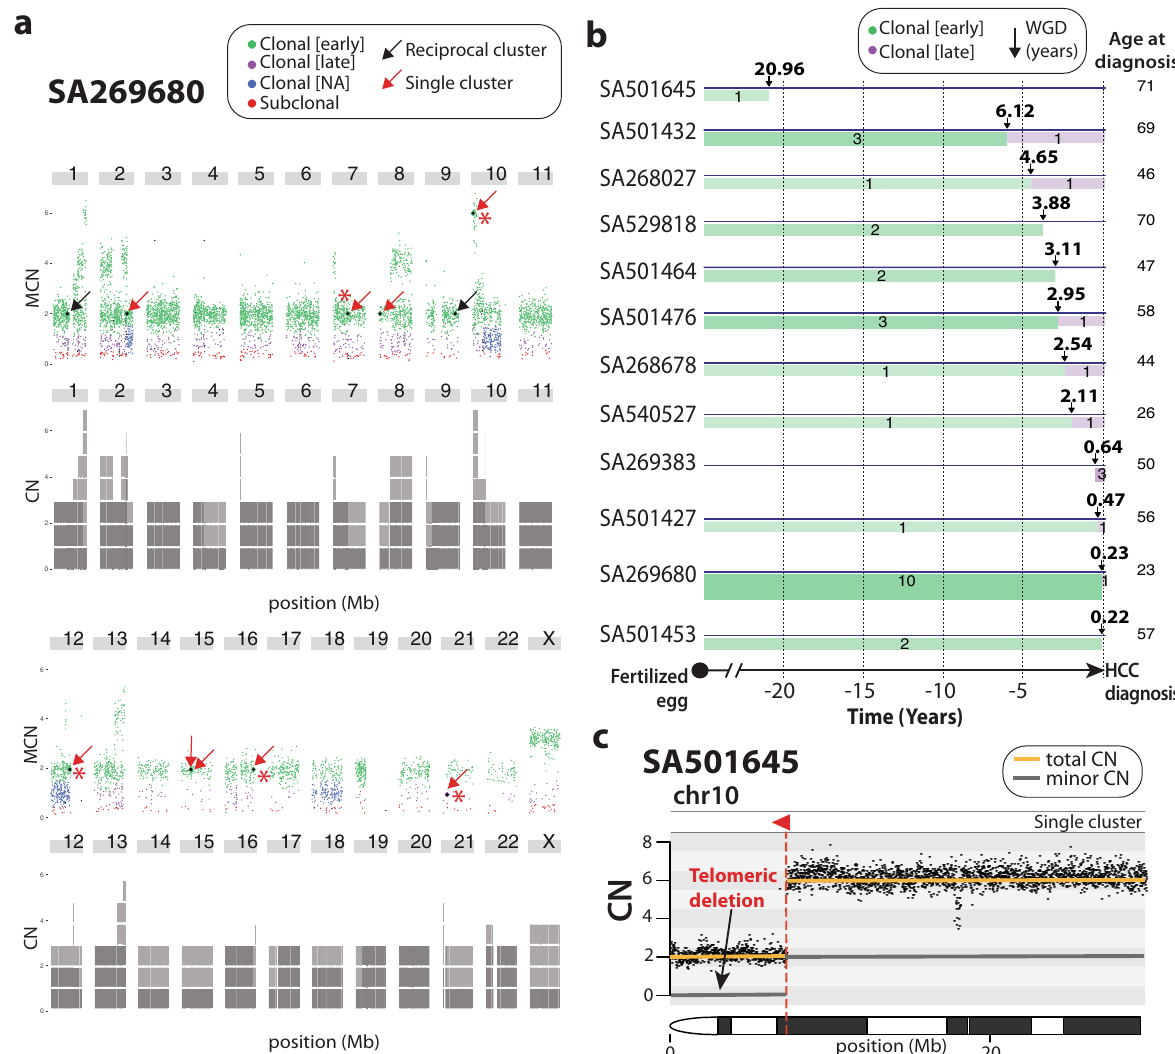
Fig. 5 HBV-mediated rearrangements are early clonal events in HCC evolution. a In SA269680, an HCC with a whole-genome duplication, HBV insertions are shown in the context of point mutation burden for that sample. Coloured dots above chromosomes represent point mutations with different timing: early clonal (before the whole-genome duplication; green), late clonal (after the whole-genome duplication; purple), clonal (blue), subclonal (red). We identi fi ed nine HBV single clusters (black dots with red arrows), all but one catalogued as early clonal events. Five of these early HBV insertions (marked with red asterisks) are associated with megabase-size telomeric deletions (see copy number plots in Supplementary Fig. 3). The same sample bears two additional early clonal HBV canonical insertions (black dots with black arrows). Grey blocks below chromosomes represent the copy number pro fi le. MCN stands for Minor Copy Number. b Real-time timing estimation of HBV insertions along patients ’ lifetime in samples with whole-genome duplication events. The X axis shows the time interval when – before (green) and after (purple) – the somatic HBV insertions took place relative to the WGD event; thickness and strength of the green and purple bars correlates with the number of events. Black arrows represent when a WGD event took place, and numbers above arrows show the time – in years – before HCC diagnosis when the WGD event has occurred. Numbers within green and purple timelines represent the number of insertion events. Numbers at the end of the timeline represent the age of the patient at diagnosis. c Copy number plot showing a single cluster that supports an HBV insertion event (red triangle) associated with a 7 Mb telomeric deletion on chromosome 10 in SA501645 that, according to Fig. 4b, occurred at least 20.96 years before HCC diagnosis. The gold line represents total chromosome CN, and the grey line is the minor chromosome above and include the deletion of TP53 in sample SA529830 copy of the loss-of-function gene RPS6KA3 31 (this rearrangement (Fig. 6), the deletion of ARID1A in sample SA501424 (Fig. 7), and is described in Fig. 3a). Second, we fi nd two unrelated deletions, in the loss of one copy of the RB1 gene in a 13q telomeric deletion patients SA268027 and SA269383, that remove one copy of the from sample SA501511 (Fig. 3b and Supplementary Fig. 2c). In IRF2 gene (Supplementary Fig. 3). Although IRF2 is not addition, although not included in the PCAWG Compendium, we catalogued in Census nor Intogen, functional studies have fi nd three additional clonal telomeric deletions removing one copy identi fi ed it as a cancer suppressor gene in HCC 31 . These results provide evidence that this is a mutational mechanism that likely of two relevant cancer genes in human HCC. First, in sample contributes to the development of human HCC. SA529726, a telomeric deletion at chromosome X removes one